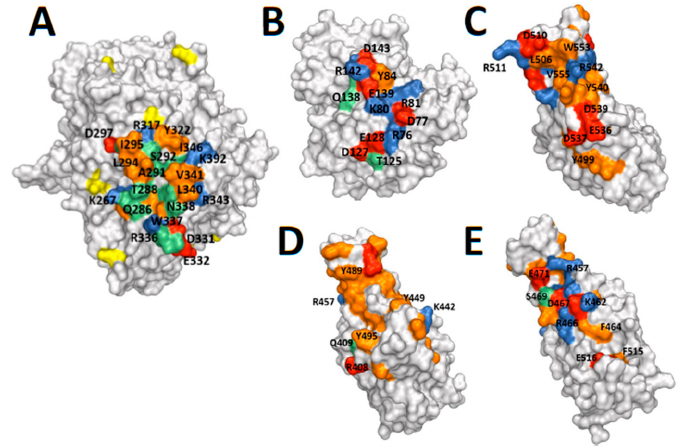
Figure 5. Protein structures. ( A ) DPP4 monomer (PDB ID 1W1I) [46]. ( B ) Adenosine Deaminase (ADA) (PDB ID 1W1I) [46]. ( C ) MERS-CoV spike RBD (PDB ID 4L72) [45], and ( D , E ) SARS-CoV-2